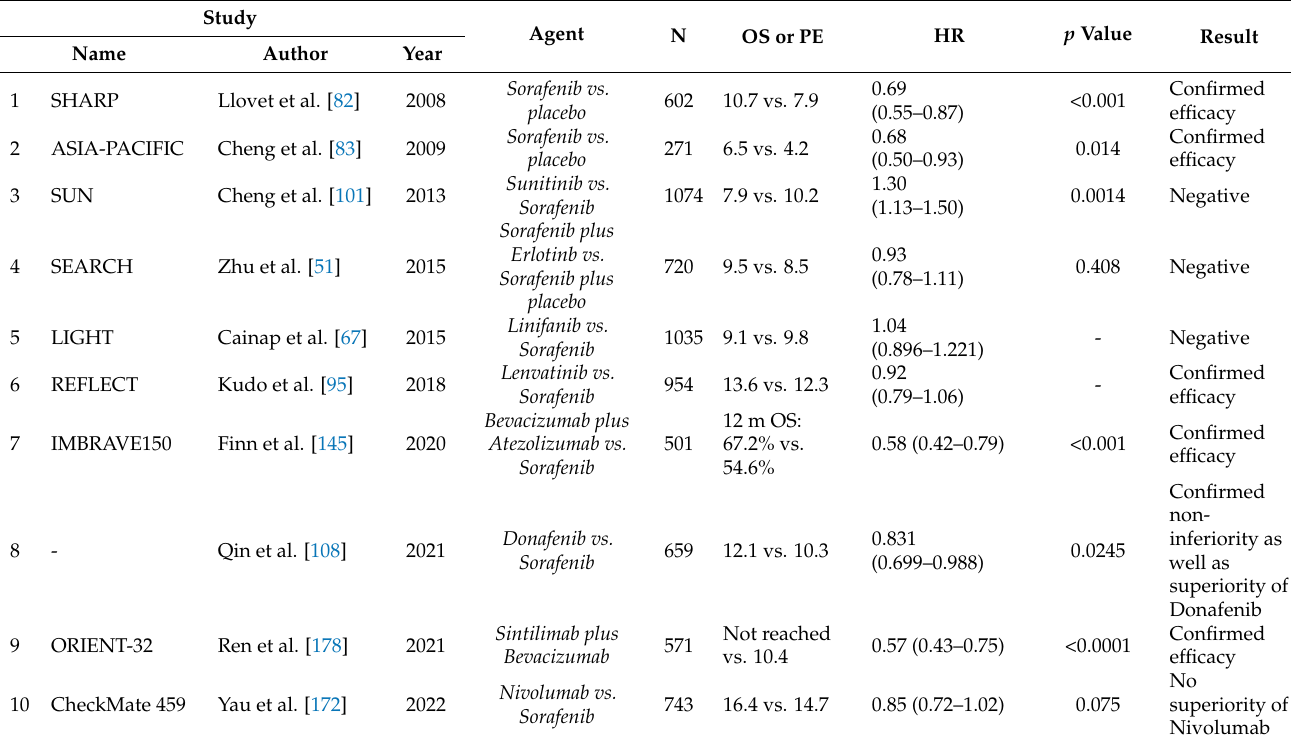
Table 1. Phase III trials that evaluated targeted agents as first-line treatment.